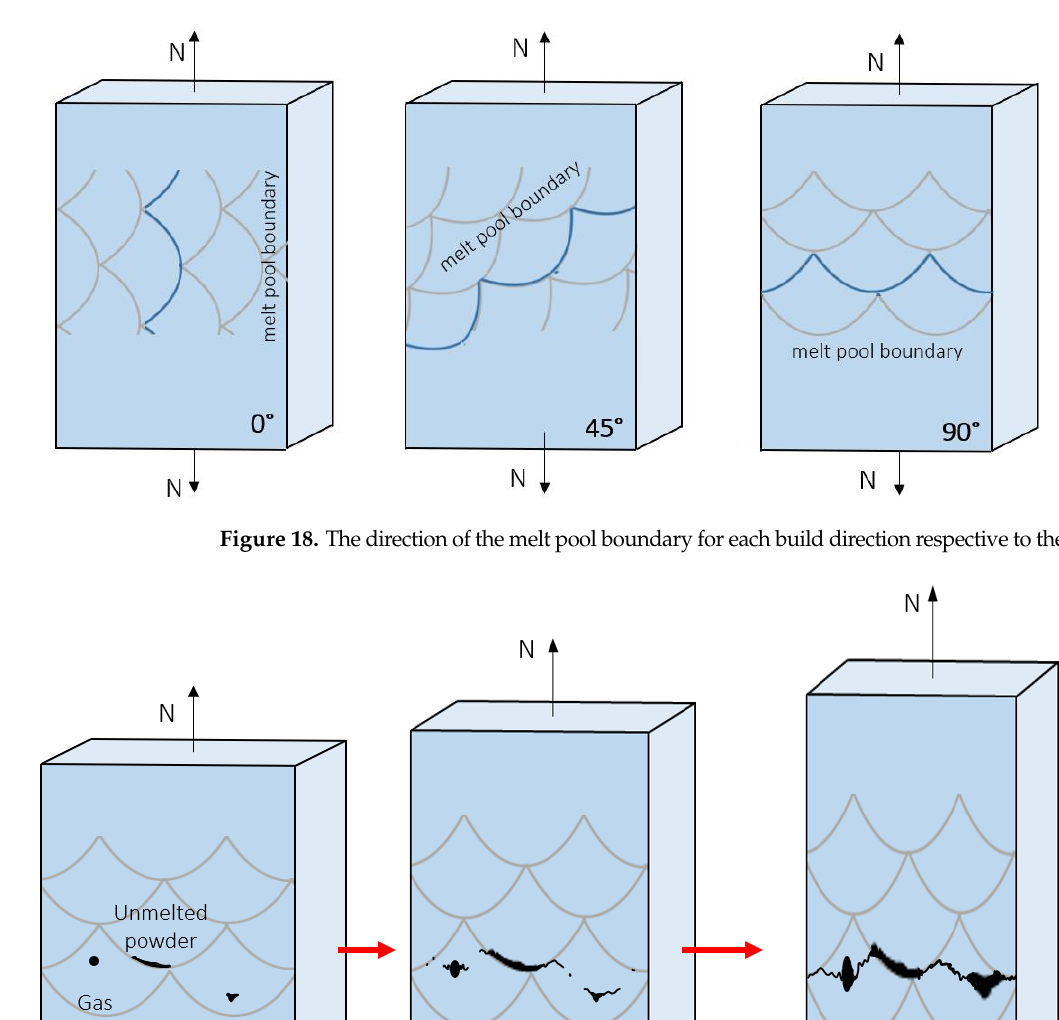
Figure 17. Stress strain curve for all build direction.